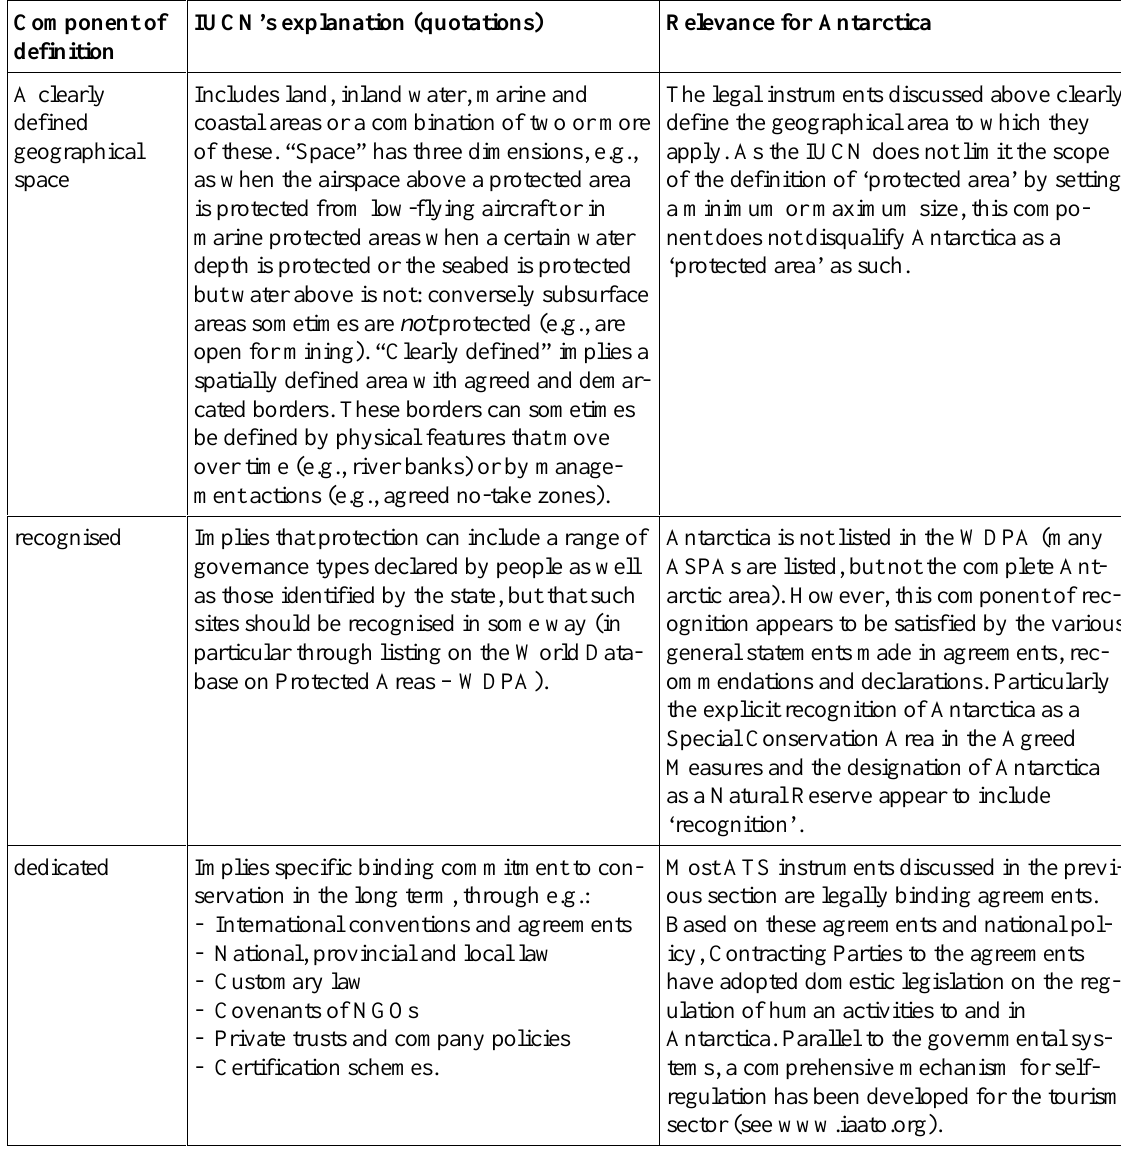
Table 1: Applying the IUCN’s definition of ‘protected area’ to Antarctica Component